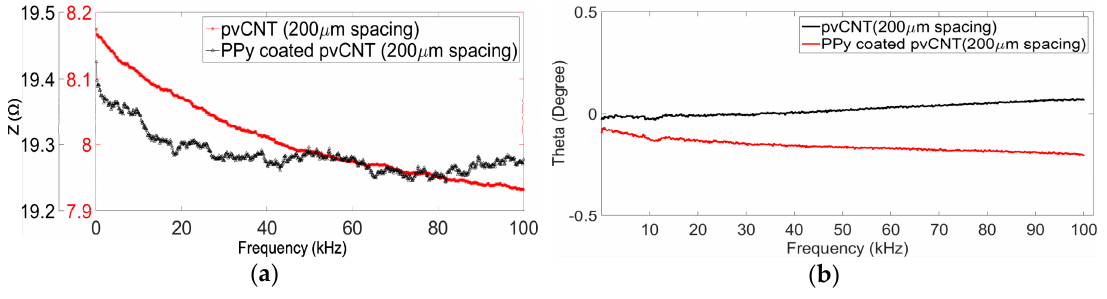
Figure 5. The amplitude ( a ) and phase ( b ) of the impedance for non-coated and PPy-coated pvCNT electrodes.